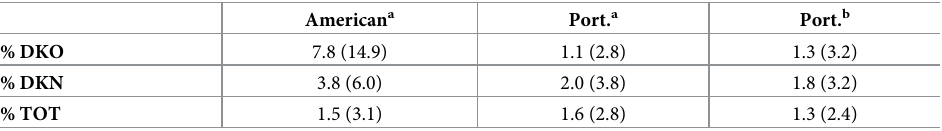
Table 4. Proportion of naming failures (DKO, DKN and TOT responses), in each